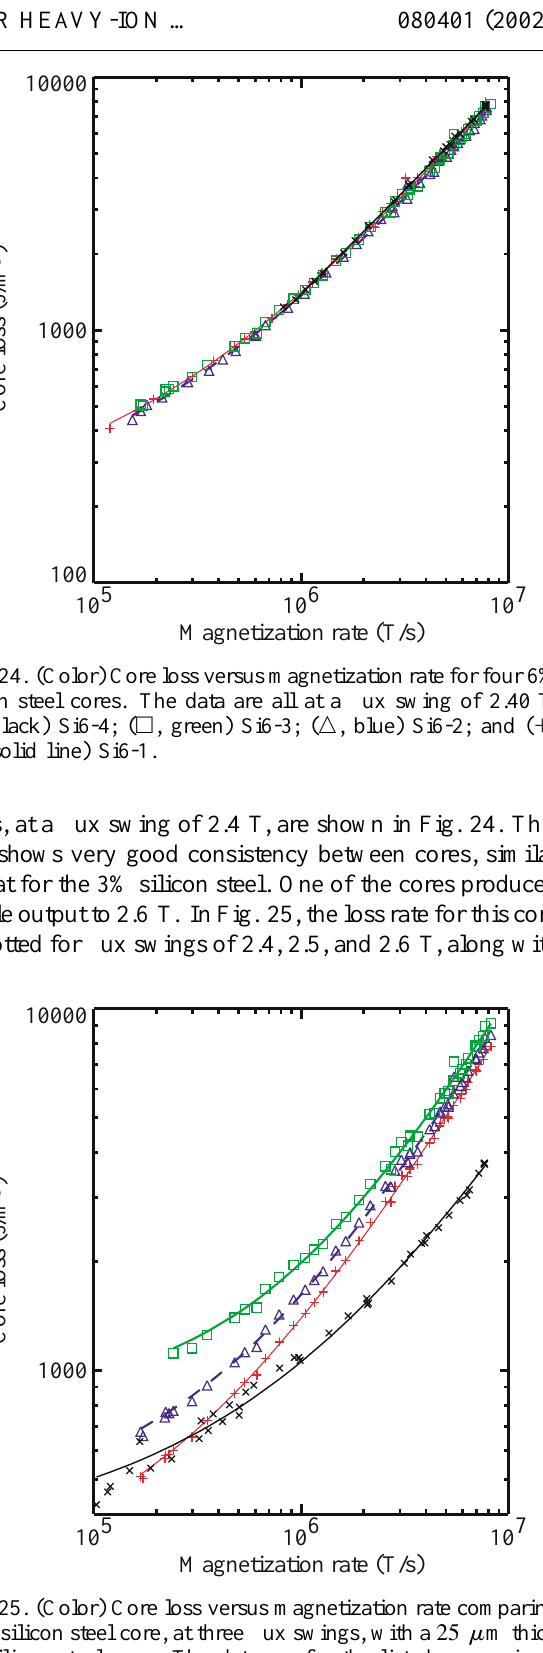
FIG. 23. (Color) Core loss versus magnetization rate for three 25 m m thick 3% silicon steel cores, manufactured by Magnetic Metals. The data are all at a flux swing of 3.0 T: ( (cid:1) , green) 3301-3; ( (cid:3) , blue) 3301-2; and ( 1 , red, solid line) 3301-1.